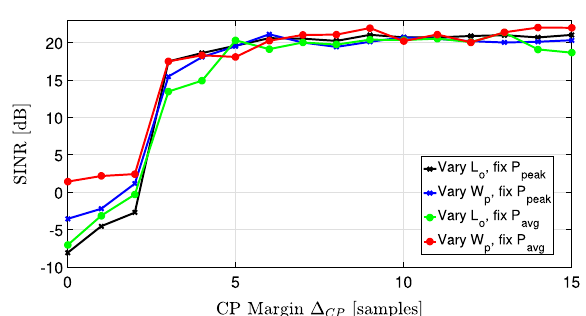
30dB and varying (cid:31) CP by either varying L o or W p and by either fixing Fig. 16 Case I: Fixing power gap (cid:31) p = the average peak power P peak or by fixing the average power P